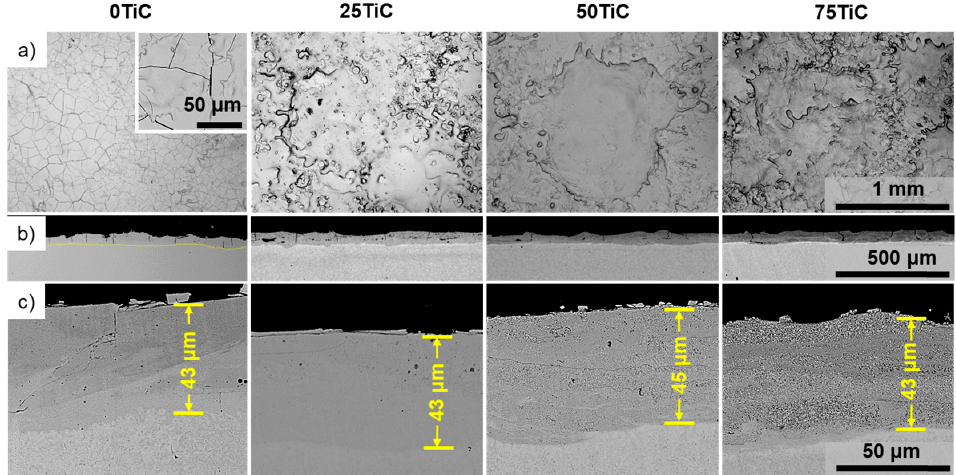
Figure 1. SEM images of TiCr-NiAl ( a ) and 50%TiC-CrTiNiAl ( b ) electrodes’ cross-sections with corresponding EDS element distribution maps and compositions of marked areas ( c ).